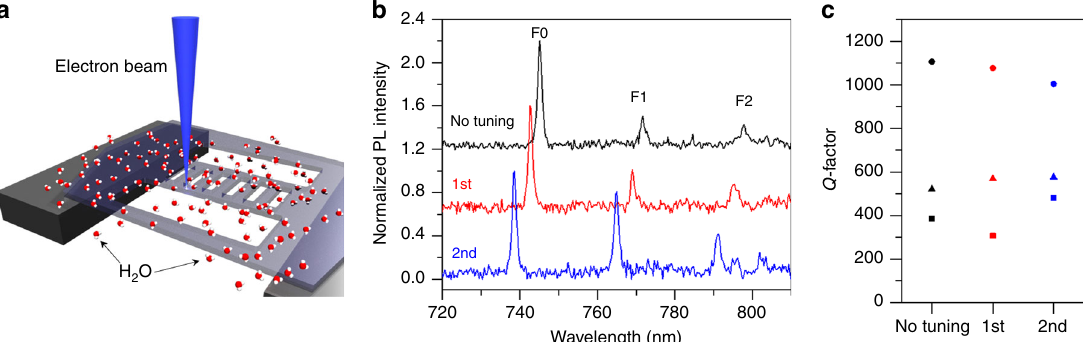
Fig. 3 Tuning of a 1D nanobeam cavity using direct-write, maskless EBIE. a Schematic of the etch process in which a focused electron beam (blue) is scanned along the outer sidewalls of the nanobeam cavity to induce the etch reaction in the presence of water molecules. b Photoluminescence (PL) spectra of a 1D photonic cavity before tuning (black), and after the fi rst (red) and second (blue) tuning steps were performed by EBIE. c Q -factor of the F0 (circles) and F1 (triangles) modes measured immediately after fabrication (black), and after the fi rst (red), and second (blue)